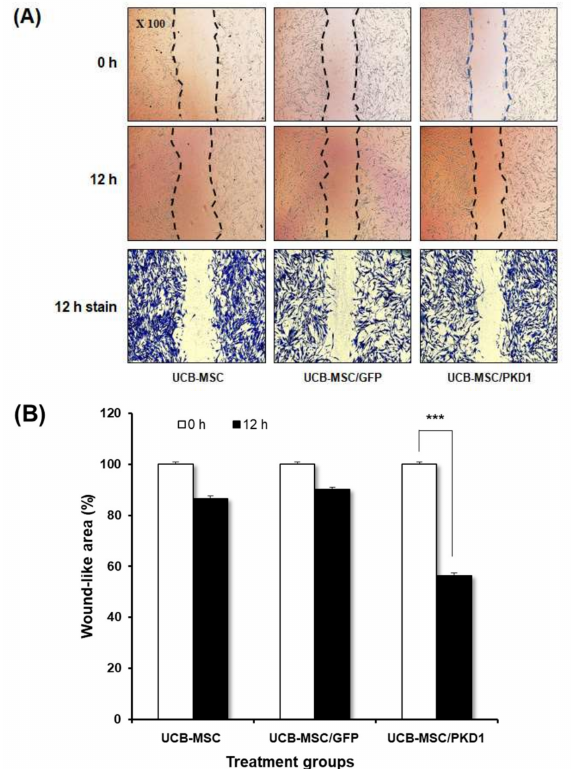
Figure 4. Improved cell migration ability of UCB-MSC by PKD1 expression. ( A ) To the migration ability of UCB-MSC in the presence of PKD1 expression, the cells were scratched by a 200 uL pipette tip. At 12 h, the cells were stained with crystal violet; ( B ) Open area was calculated using image J and quantified by percentage values. Data shown represent the mean ± SD ( n = 3). *** p < 0.01 for the comparison of 0 h and 12 h in PKD1 expressing